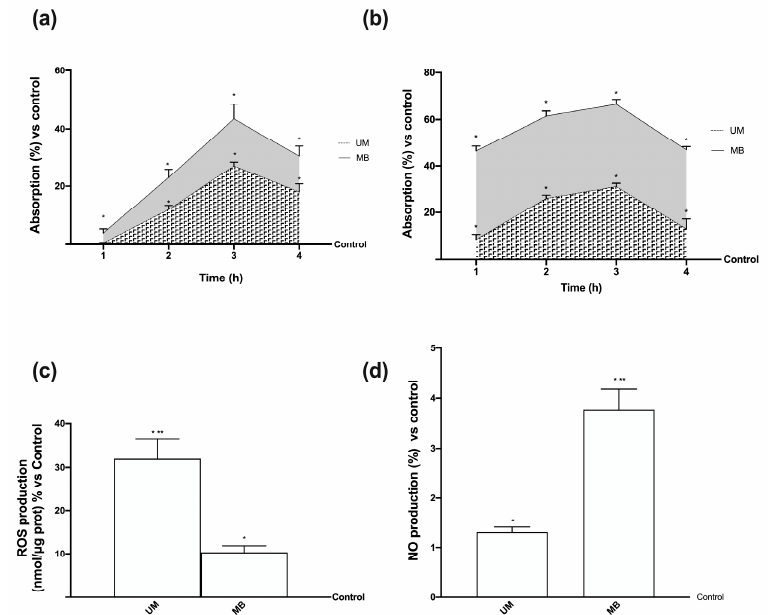
Figure 5. Magnesium quantification and ROS / NO balance produced on PHM1-41 cells. ( a ) Total Mg absorbed in co-culture model measured at the basolateral level over time (ranging from 1 h to 4 h). ( b ) Total Mg absorbed at the intracellular level over time (ranging from 1 h to 4 h). Data are means ± SD (%) compared to control values (line 0%) of four independent experiments produced in triplicate. * p < 0.05 vs. control; p < 0.05 between UM and MB at the same time point across all time points. ( c ) ROS analysis measured at 3 h expressed as means ± SD (%) of cytochrome C reduced / µ g of protein normalized to control (line 0%) of five independent experiments produced in triplicate. * p < 0.05 vs. control; ** p < 0.05 vs. MB. ( d ) NO production measured at 3 h normalized to control (line 0%) and expressed as means ± SD (%) of five independent experiments produced in triplicate. * p < 0.05 vs. control; ** p < 0.05 vs. MB. The abbreviations are the same as reported in Figure 1.